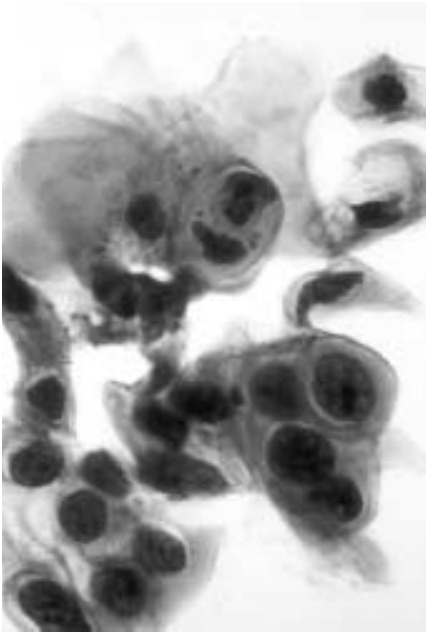
Fig. 3. Brushing smear of a carcinoma in situ of the conjunctiva. Polymorphous abnormal squamous cells revealing keratinisation. Magnification 63 × .